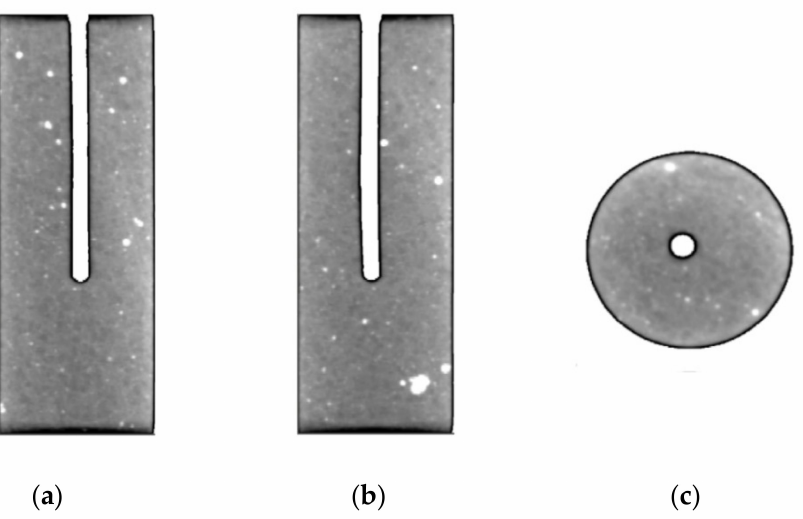
Figure 2. CT scan images of the axial rock center, x-z plane ( a ), y-z plane ( b ), and x-y plane in the center of the sample ( c